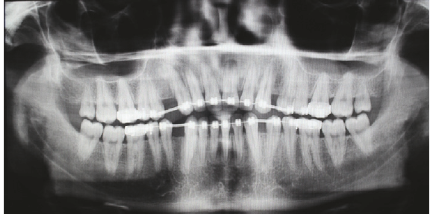
Figure 3: Panoramic view indicating root proximity between canines and second premolars in left side after orthodontic treat- ment.